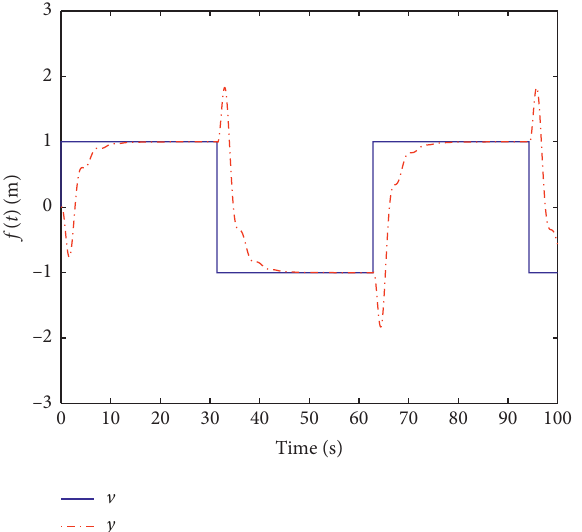
Figure 14: Control system response of sign ( sin ( 0 . 1 t )) .